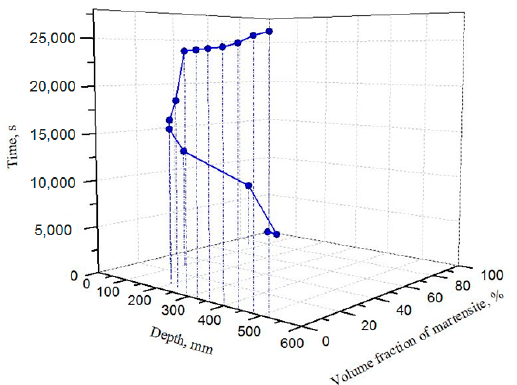
Figure 11. Calculated martensite distribution for condition (D).